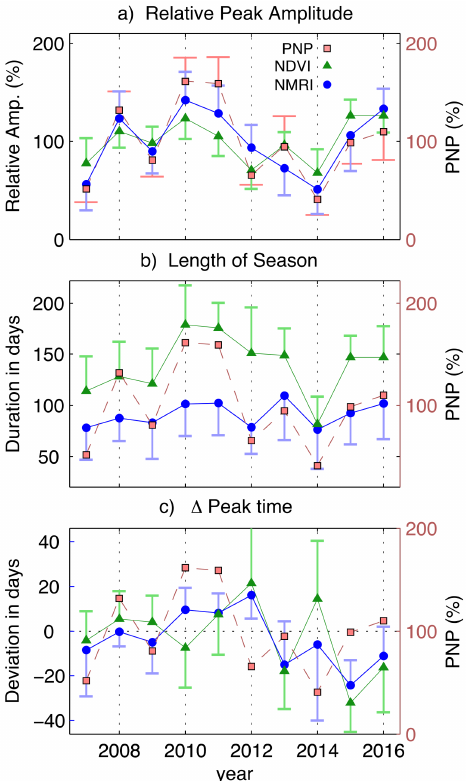
Figure 8. Central California averaged (inset Figure 1, 55 sites) phenology metrics and one standard deviation as a function of year during 2007–2016, using NDVI (green triangles) and NMRI (blue circles); ( a ) Relative Amplitude; ( b ) Length of Season; and, ( c ) Deviation in time of peak growth. The averaged PNP is displayed in all plots (pink squares), with one standard deviation shown only in ( a